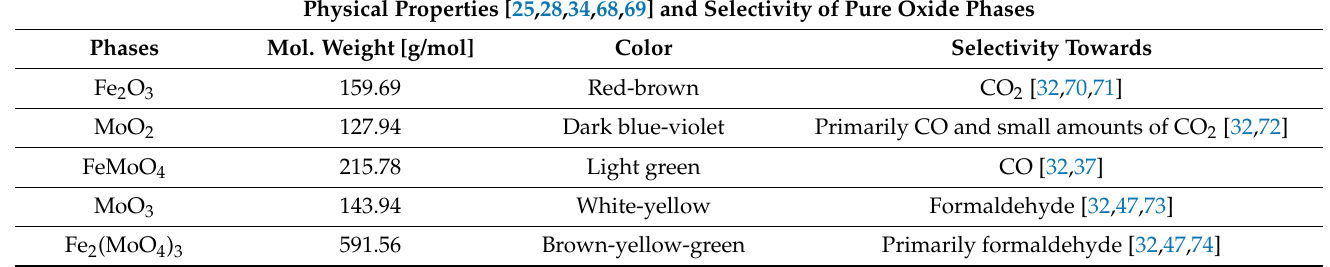
Table 1. Represents the physical property and selectivity of each oxide in iron molybdate catalyst. Physical Properties [25,28,34,68,69] and Selectivity of Pure Oxide Phases Phases Mol. Weight [g/mol] Color Selectivity Towards Fe 2 O 3 159.69 Red-brown CO 2 [32,70,71] MoO 2 127.94 Dark blue-violet Primarily CO and small amounts of CO 2 [32,72] FeMoO 4 215.78 Light green CO [32,37] MoO 3 143.94 White-yellow Formaldehyde [32,47,73] Fe 2 (MoO 4 ) 3 591.56 Brown-yellow-green Primarily formaldehyde